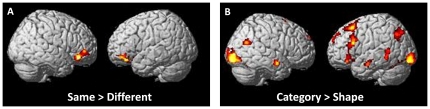
Activation during abstraction and similarity detection.Activation is displayed on a rendered brain. Only clusters surviving a family-wise error (FWE) correction (p<.05) are reported (cluster extent: 150 voxels). Details regarding activated foci are displayed in table 1.